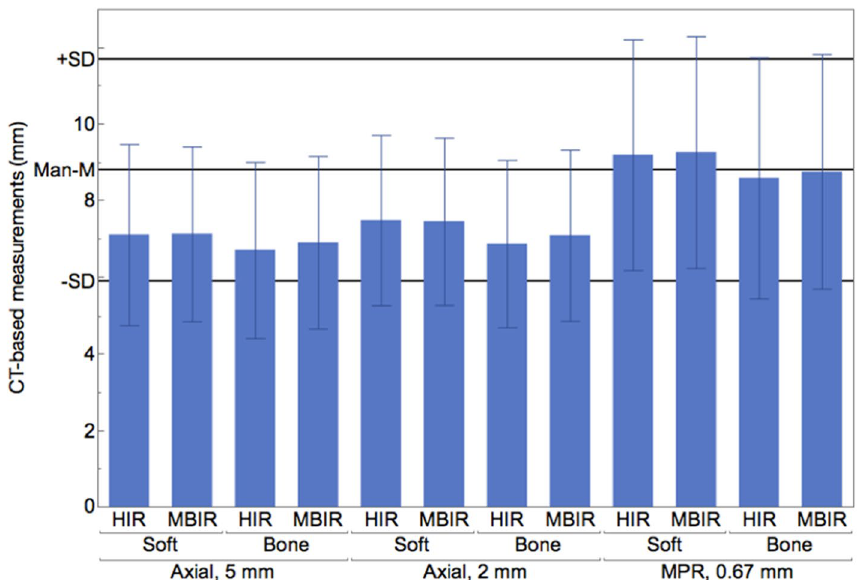
Figure 2. Computed tomography (CT) based measurements of kidney stone size performed on multiplanar reformatations (MPR) using a bone window setting in images reconstructed with a model-based iterative reconstruction algorithm (MBIR) (8.8 ± 3.1 mm) showed closest agreement with Man-M (8.8 ± 2.9 mm) compared to axial reformatations, a soft-tissue window setting and hybrid-iterative reconstruction algorithm.